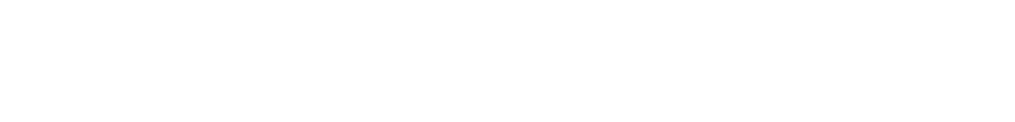
Frontiers in Energy Research | Energy Systems and